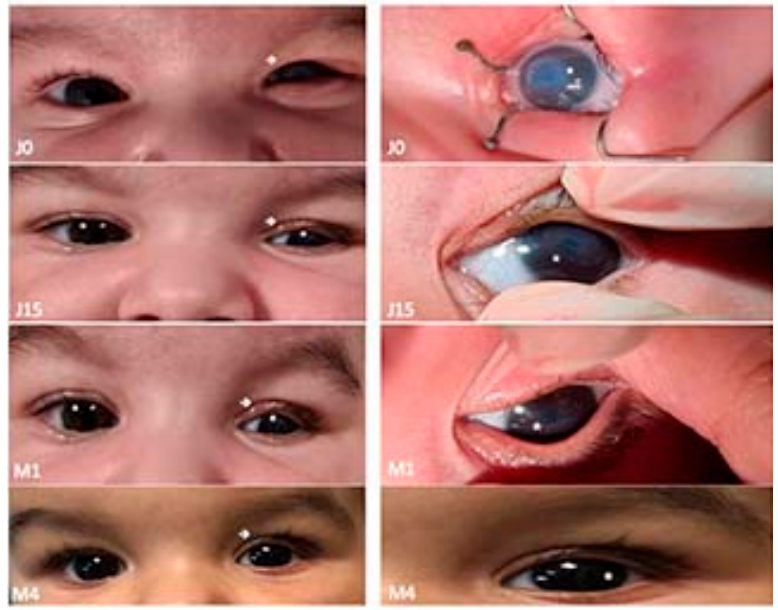
Figure 4. Favorable evolution and improvement in the position of the upper eyelid of the left eye and disappearance of the central corneal leucoma four months after surgery (personal collection).